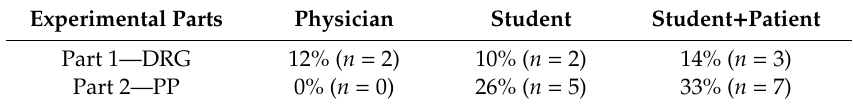
Table A10. Proportion of participants with decision changes within parts 1 and 2.